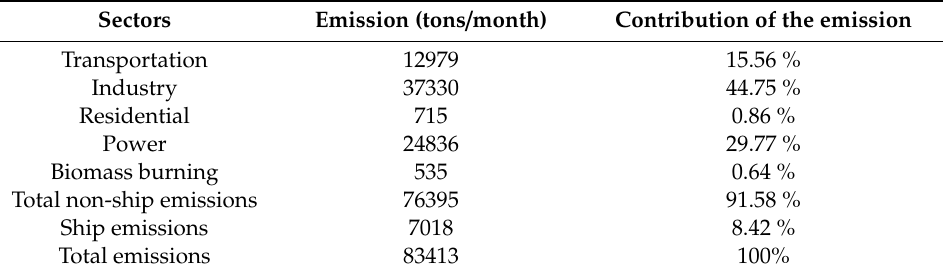
Figure 1. Sketch map of the study area. Table 1. Input data of land-based and ship